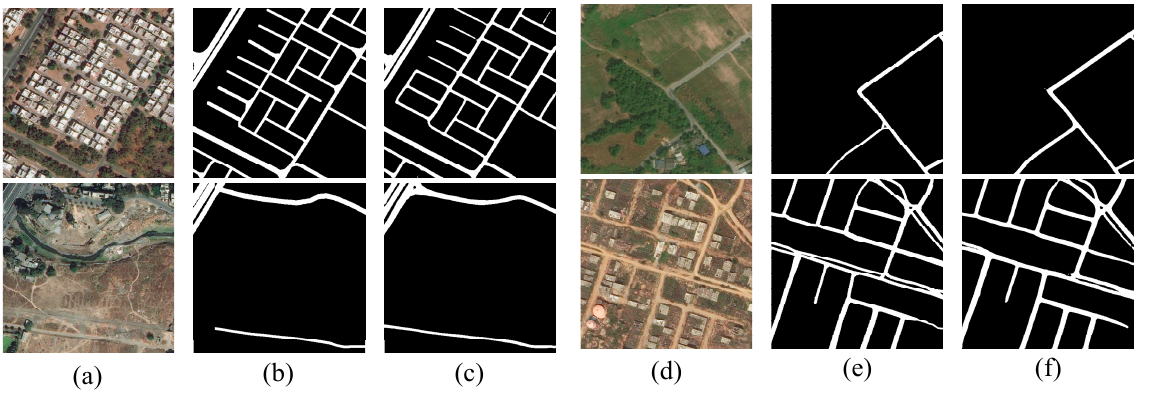
Figure 4. The results of road extractions using the proposed GMR-Net model. ( a , d ) Original images, ( b , e ) corresponding ground truths, and ( c , f ) predictions from the GMR-Net method.